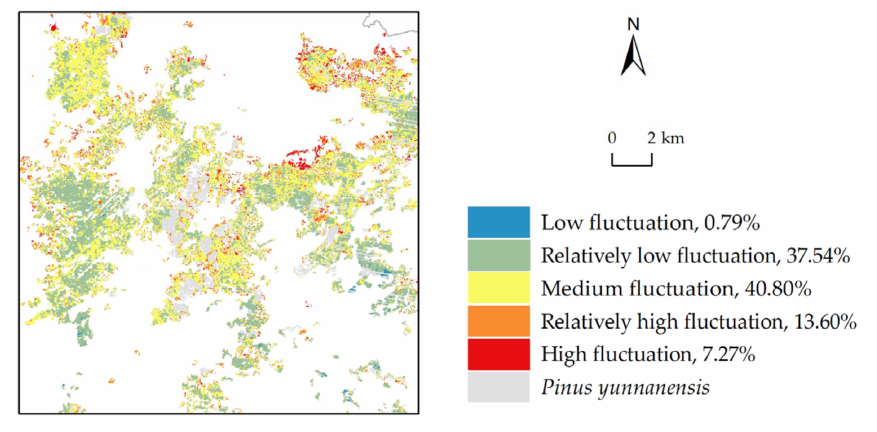
Figure 11. Spatial distribution of CV NDVI in Yunnan pine forests from 2009 to